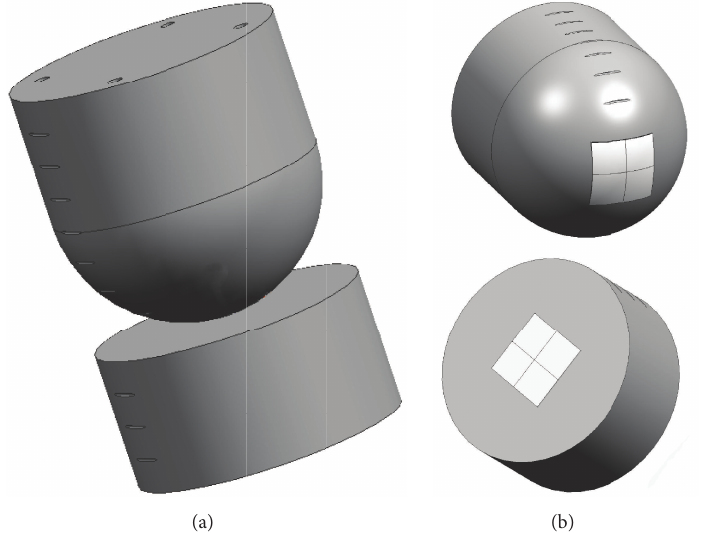
Figure 8: Sample of electrical contact (a); roughness surface test zone (b).